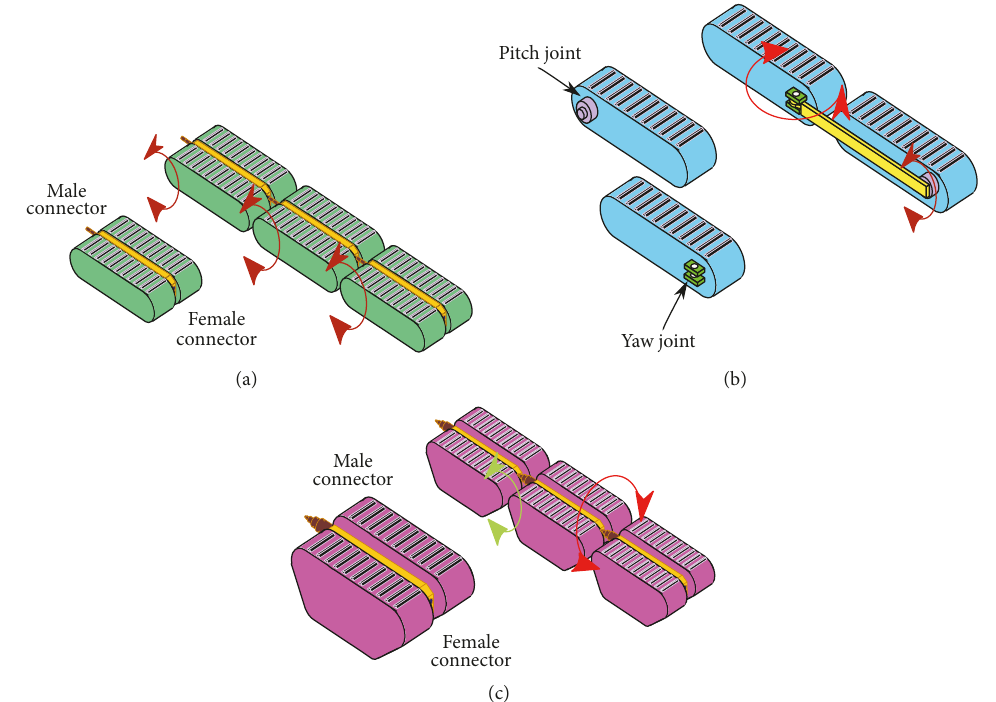
Figure 7: Chain structured mobile MSRR hardware models and structures: (a) Millibot, (b) Amoeba, and (c) JL-1.